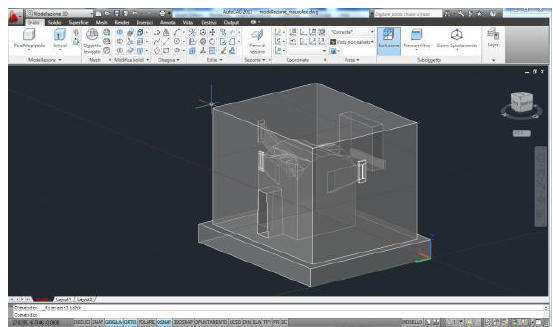
Figure 9. Volumetric 3D model with autoCAD